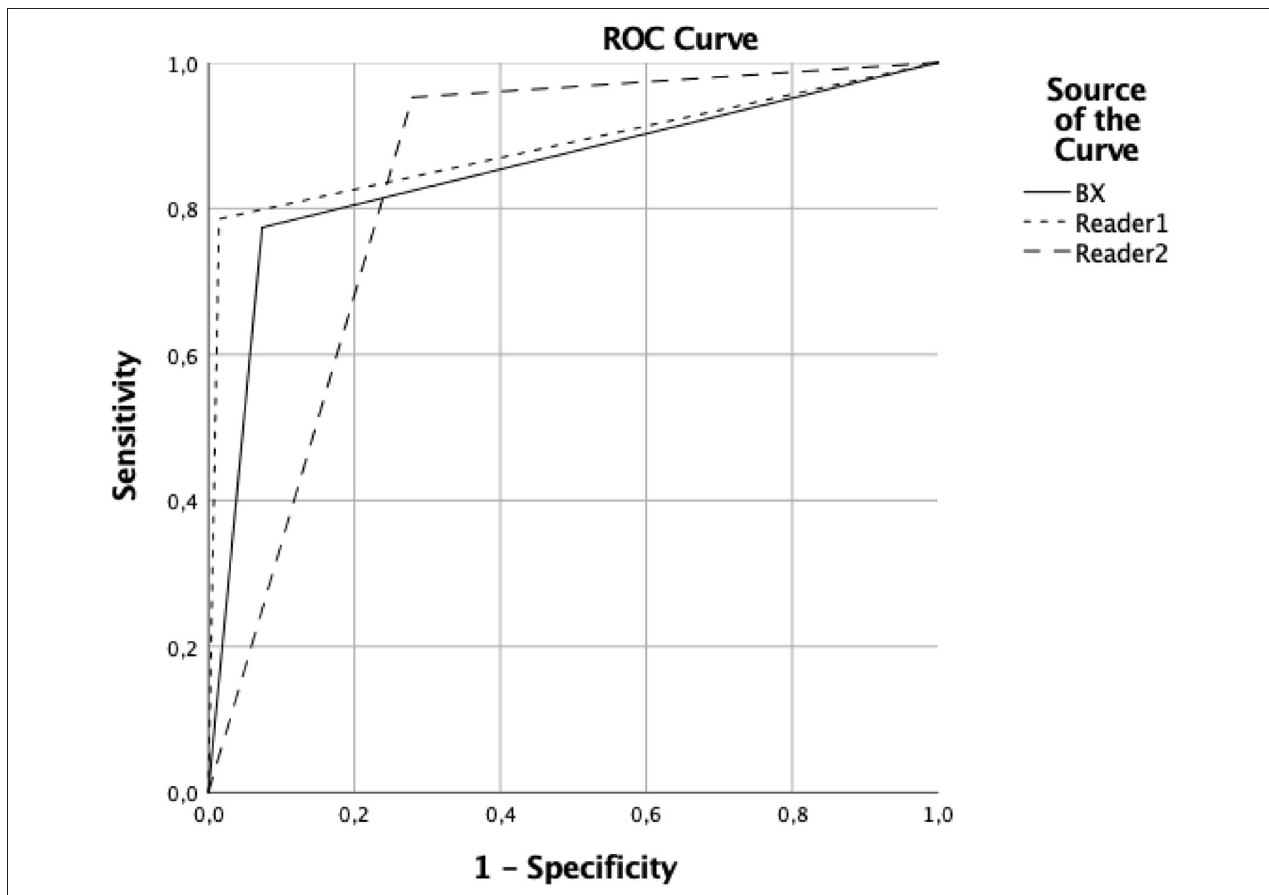
FIGURE 2 | Receiver operating curves (ROC) for the software and 2 human readers ROC curves showing the accuracy of detecting hyperdense artery signs by the software (BX) and two human readers (Readers 1 and 2).